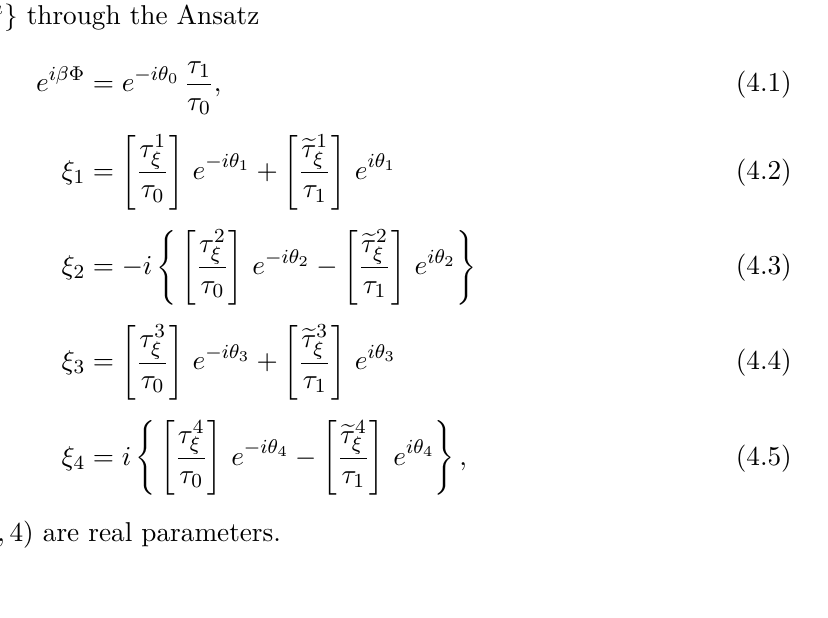
order to find 1-soliton type solutions as in the generalized sine-Gordon models [19] and, sometimes, in order to construct the two-soliton solutions, as in the non-integrable modified regularized long wave equation (mRLW) [50,